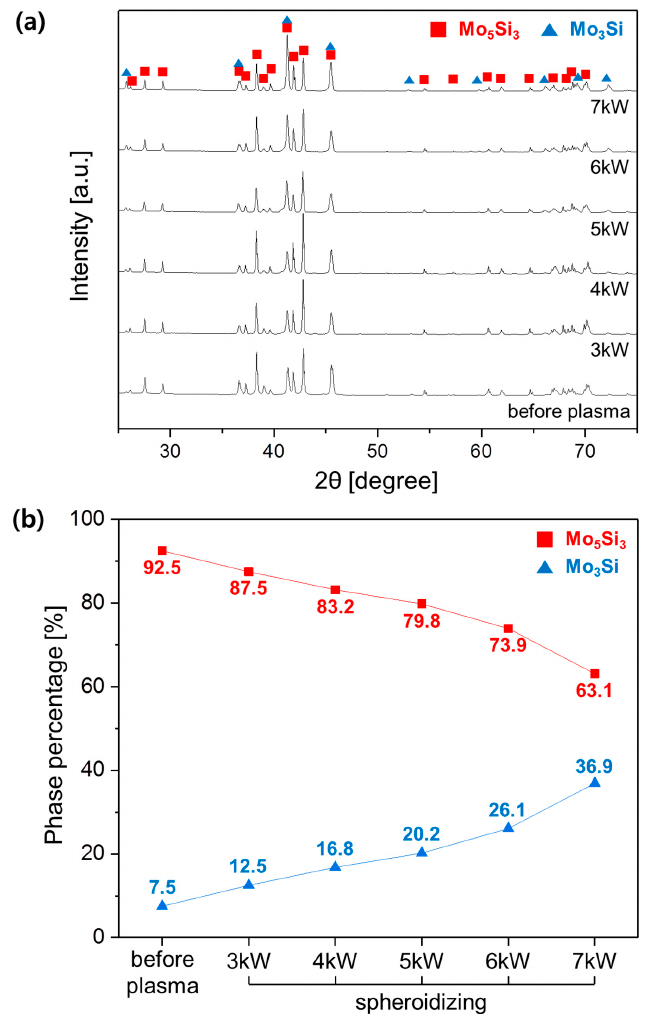
Figure 3. ( a ) XRD patterns of the powders before and after spheroidizing by inductively coupled thermal plasma treatment. ( b ) The percentage of each phase in the powders was analyzed by the Rietveld method based on the XRD data in Figure 3a.